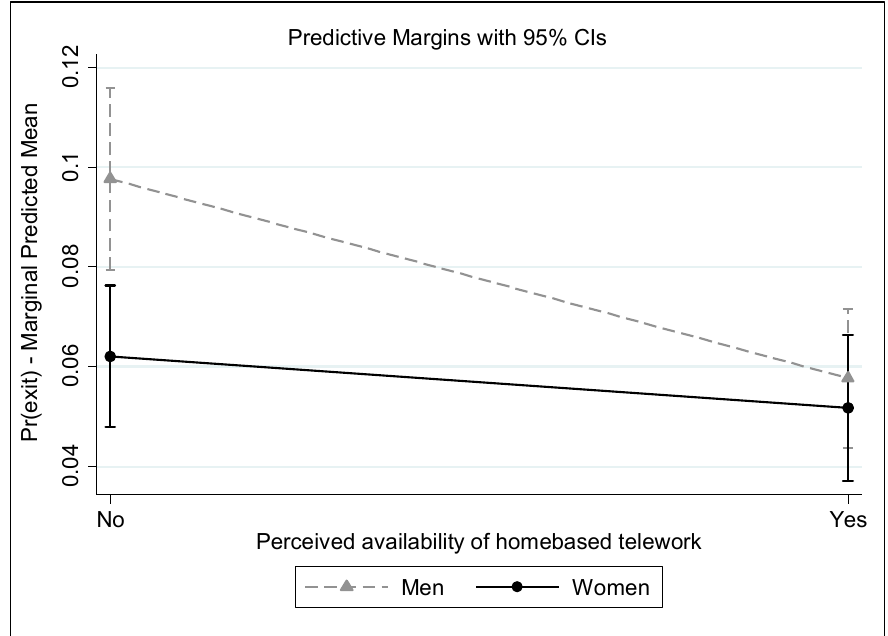
Figure 2. Predictive margins of gender differences in the association between the perceived availability of home-based teleworking and voluntary employee exit. Note. Predictive margins of gender and home-based teleworking with 95% CIs using stata are based on the mixed-effects regressions in Table 4.